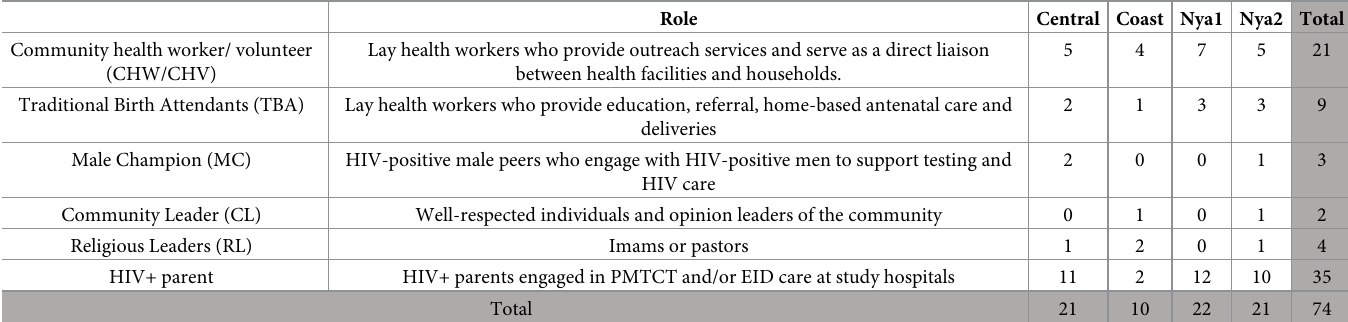
Table 1. Description and distribution of participant type included in this